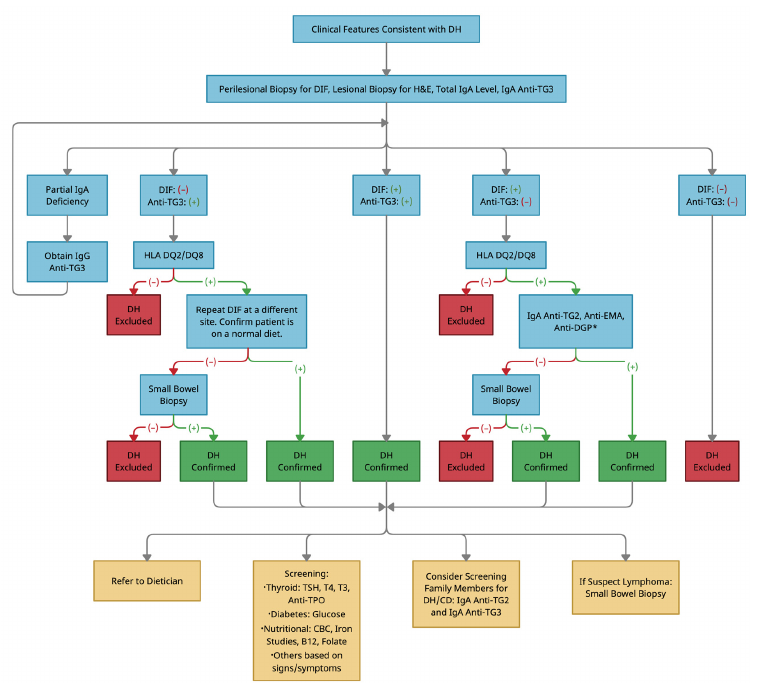
Figure 3. Diagnostic algorithm for a rash suspected of dermatitis herpetiformis. Abbreviations: DH, dermatitis herpetiformis; DIF, direct immunofluorescence; H&E, hematoxylin and eosin; IgA, immunoglobulin A; Anti-TG3, anti-epidermal transglutaminase antibodies; IgG, immunoglobulin G; HLA, human leukocyte antigen; Anti-TG2, anti-tissue transglutaminase antibodies; Anti-EMA, anti-endomysial antibodies; Anti-DGP, anti-deamidated gliadin peptide antibodies; TSH, thyroid stimulating hormone; T4, thyroxine; T3, triiodothyronine; Anti-TPO, anti-thyroid peroxidase antibodies; CBC, complete blood count; CD, celiac disease. * denotes obtaining IgG antibodies instead of IgA antibodies in the case of partial IgA deficiency.